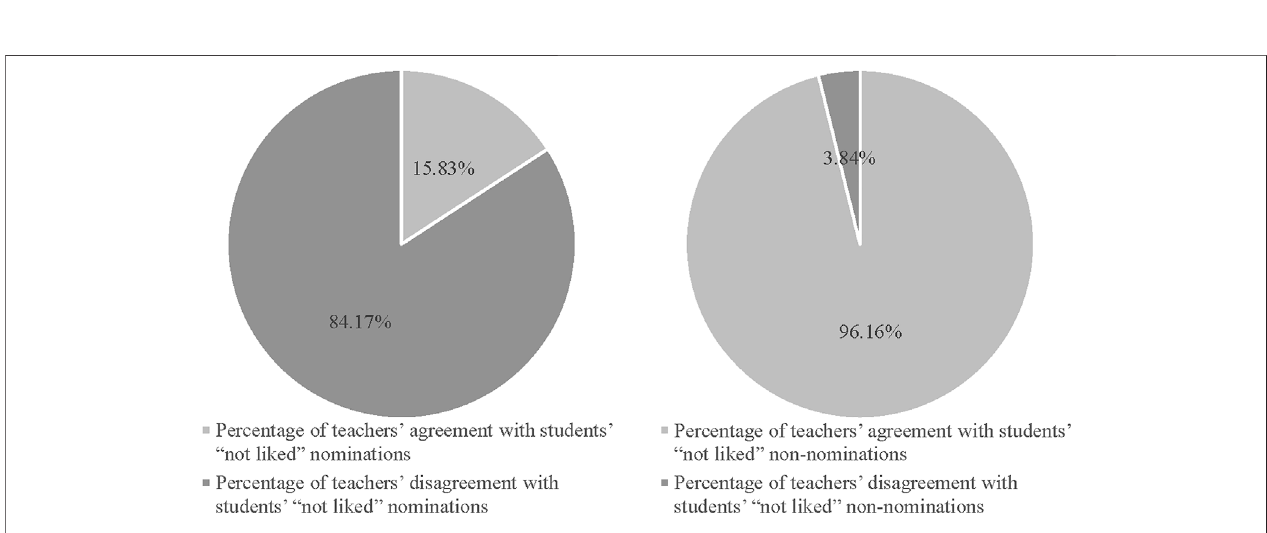
FIGURE 1 | Teachers ’ agreement with students ’ “ liked ” nominations and “ liked ” non-nominations.